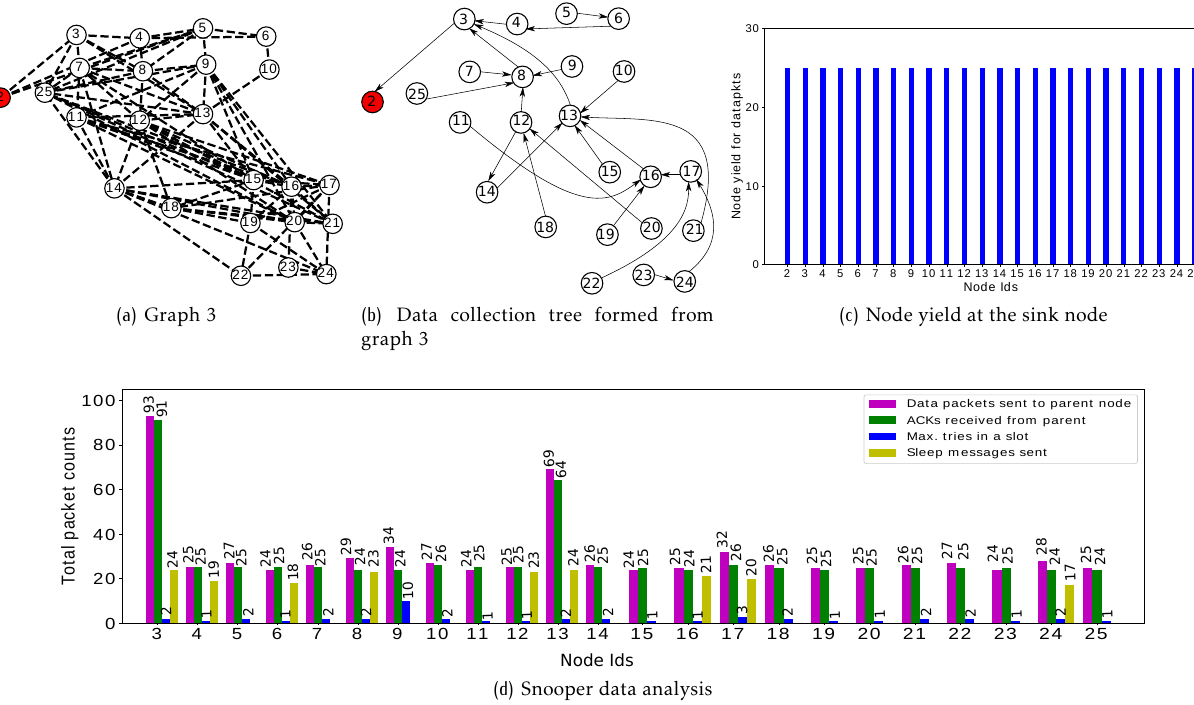
Figure 31. Graph, respective data collection tree and the packet transmissions in the network - round 3, test case